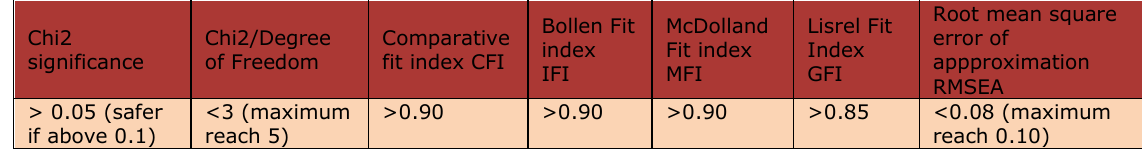
Table 7. Suitable values for satisfactory adjustment of the model (Tari et al., 2007; Sila, 2007; Hair, Anderson, Tatham, & Black, 1995; Ullman & Bentler, 2004; Spreitzer,